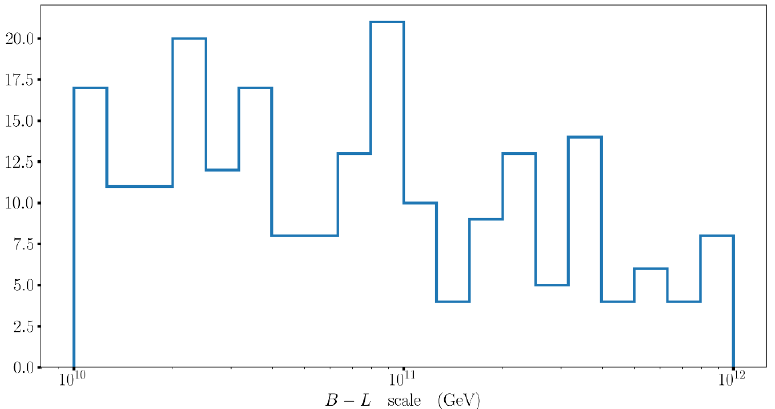
Figure 6. Distribution of the B - L breaking scale for the 215 black points displayed in (cid:12)gure 5. The vertical axis labels the number of valid black points.